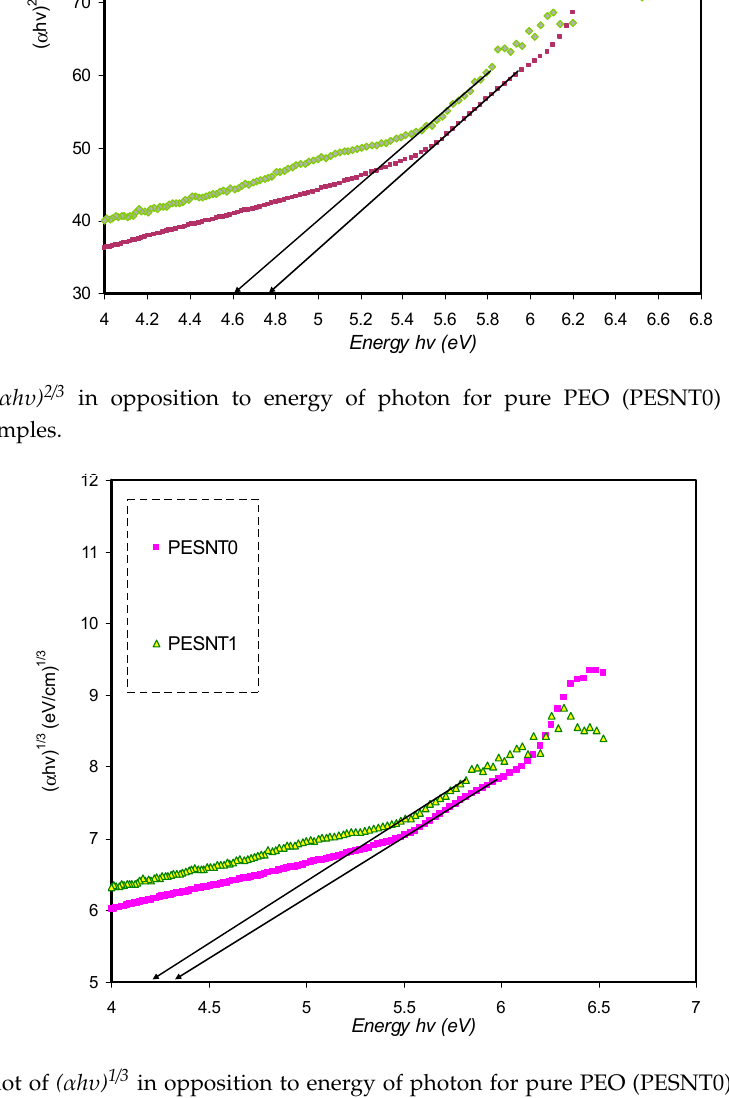
Figure 10. Plot of ( α h υ ) 1 / 3 in opposition to energy of photon for pure PEO (PESNT0) and PESNT1 composite samples.